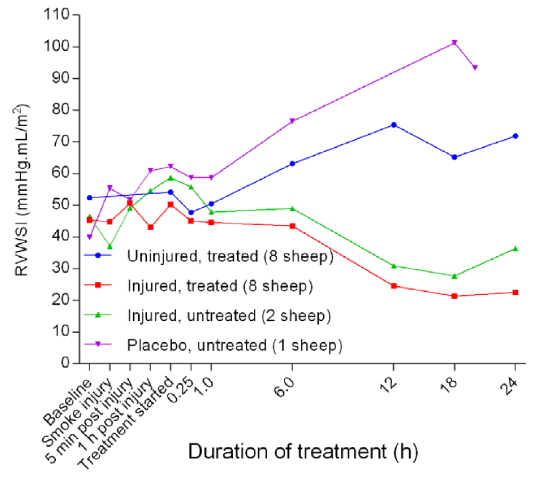
Figure 34. Left ventricular stroke work index (Mean ± SD error bars not shown) in smoke and non-smoke injured sheep that received extracorporeal life support as compared to that in untreated controls.